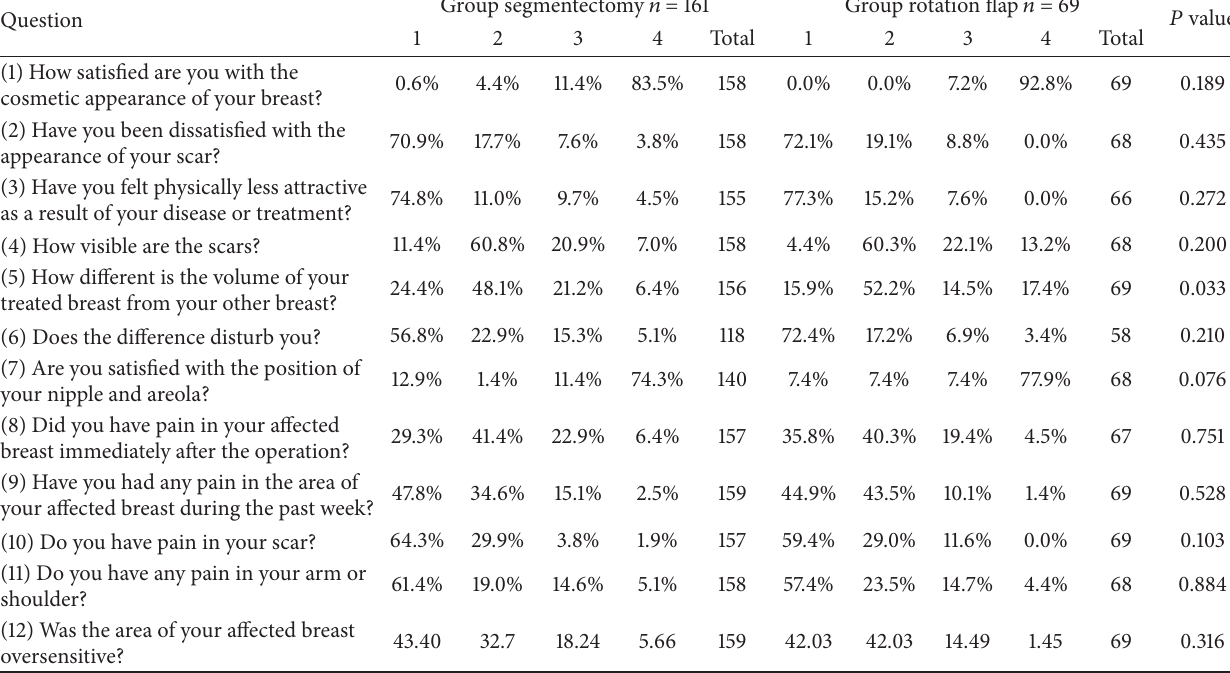
Table 2: Patients’ answers to the main questions and significance of the differences between the segmentectomy group and rotation flap group.